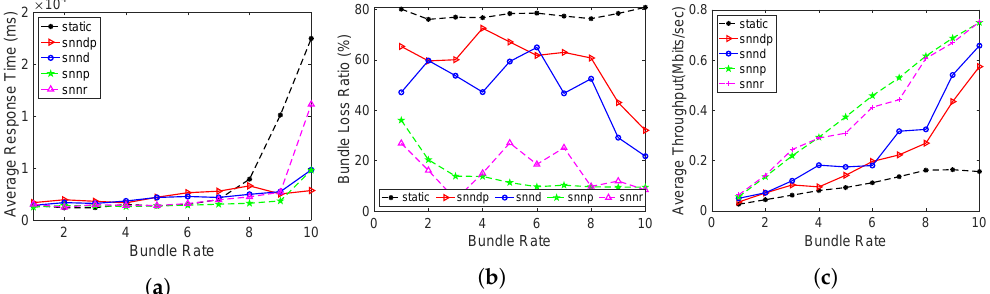
Figure 13. Routing performance: Scenario 6. ( a ) Average response time; ( b ) Packet loss ratio (%); ( c )